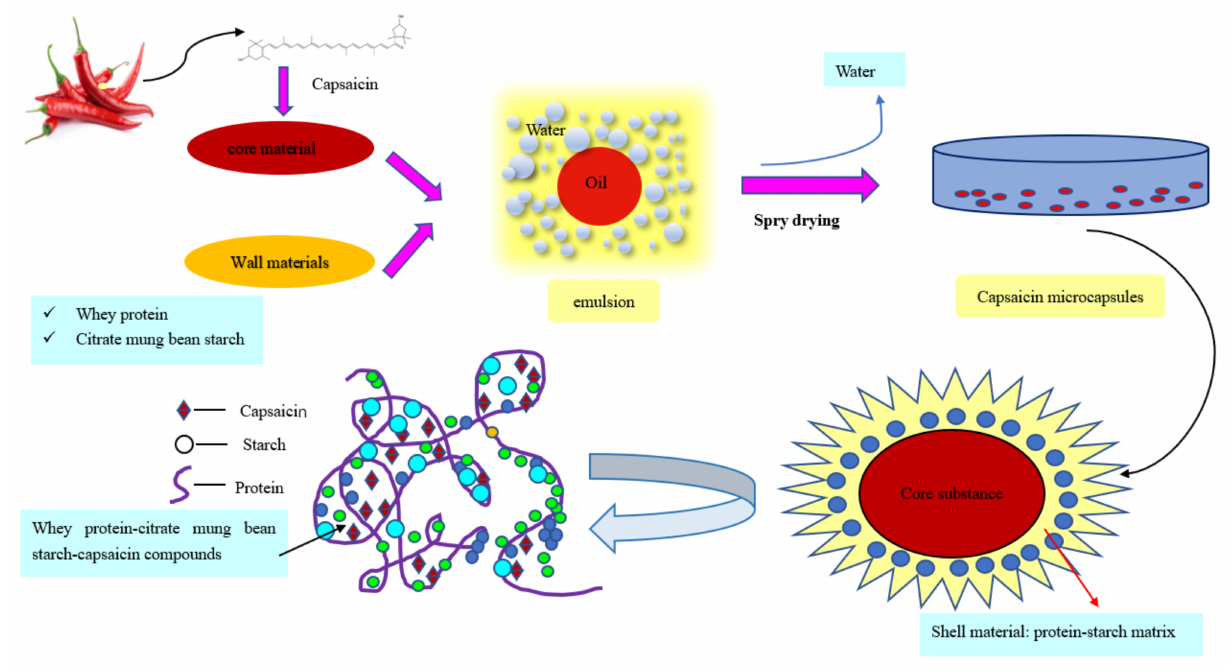
Figure 4. Mechanism of capsaicin encapsulation by starch and